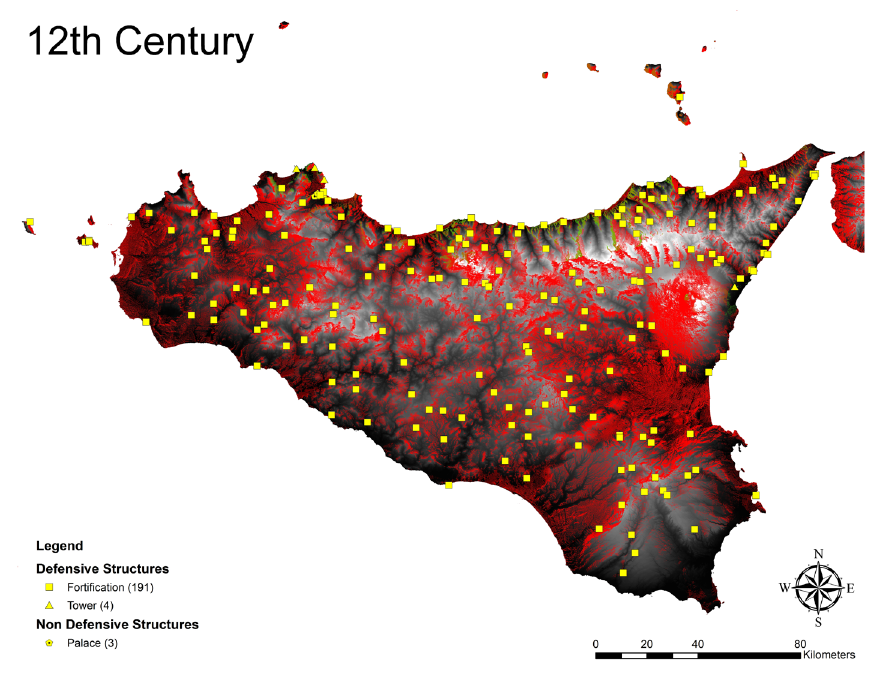
Figure 3. Figure showing the distribution of defensive structures and their viewsheds in the 12th century. Fortifications are represented by squares and the area they have surveillance over is in red whereas towers are represented by triangles and the area they have surveillance over is in green. Also included are palaces represented by hexagons. Image derived from an ASTER GDEM (a product of NASA and